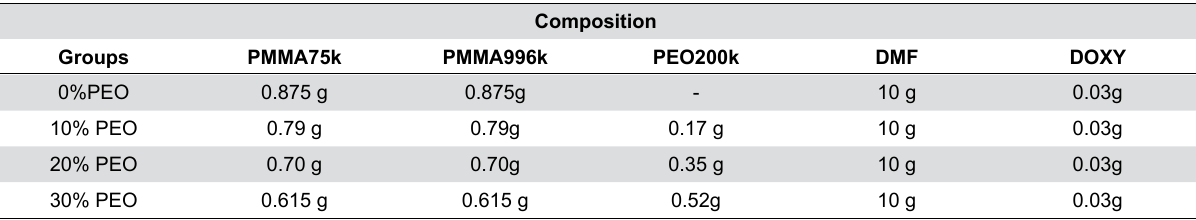
Table 1- Concentrations of polymers, solvent, and drug added to the spinning